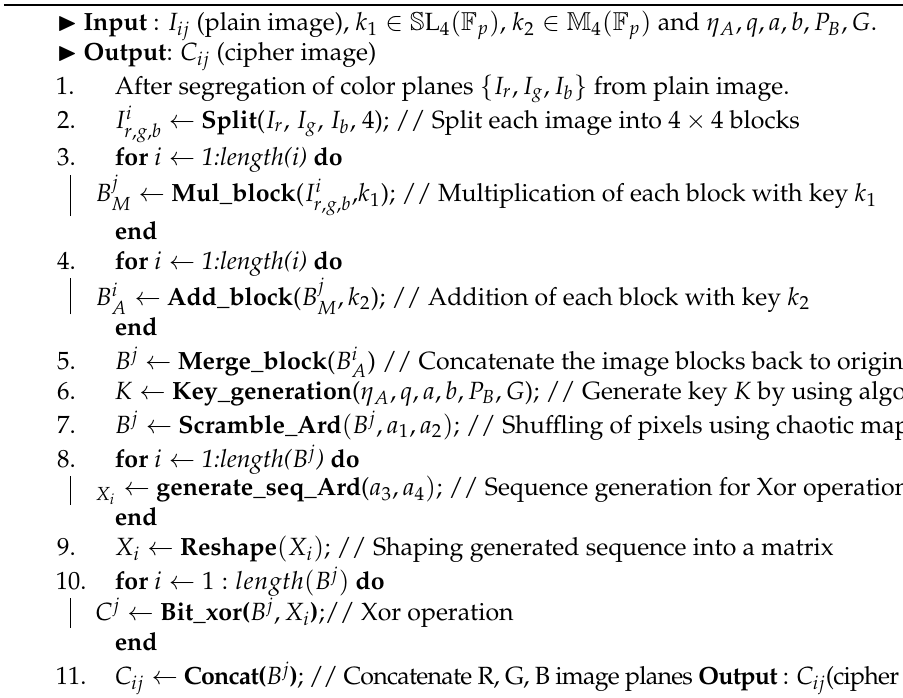
Algorithm 3: P ROPOSED ENCRYPTION